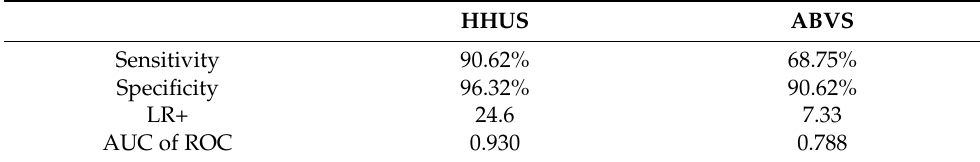
Table 1. Diagnostic performance (AUC, sensitivity, specificity, LR+) of HHUS and